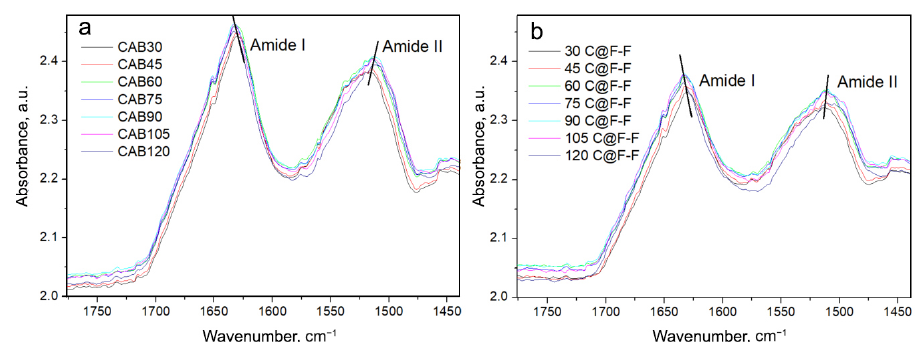
Figure 4. ( a ) ATR converted spectra of native CAB recorded at different temperatures. ( b ) CAB spectra were obtained after subtraction of CAB@Ferria and Ferria spectra (named C@F-F), at dif- ferent temperatures with a minimized difference. Amide I and Amide II frequency regions are presented. The lines indicate the tendency to shift the maxima of Amide I and Amide II bands with the temperature